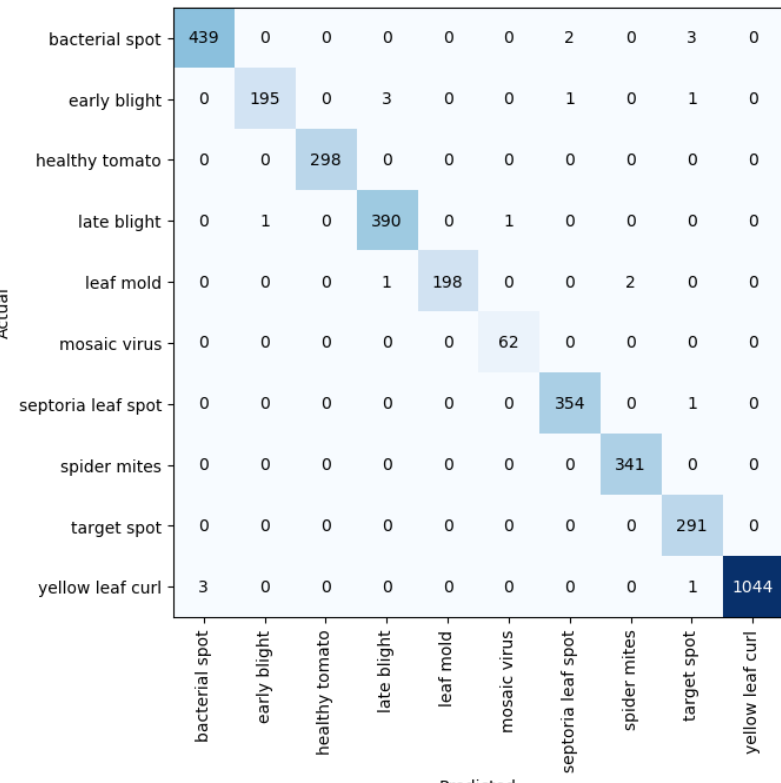
Figure 4. Confusion matrix for network depth = 101.